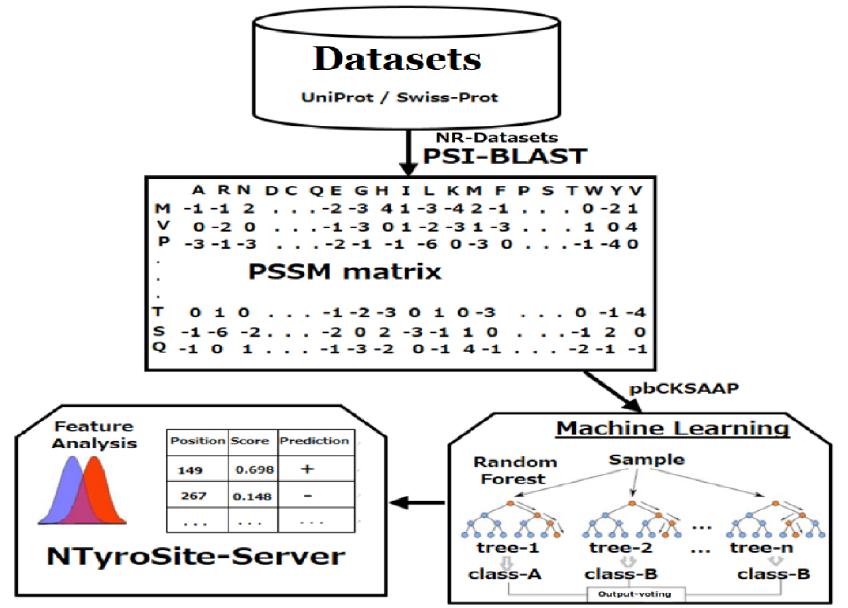
Figure 1. A computational framework of the proposed NTyroSite. NR—non-redundant; PSI-BLAST; PSSM—position-specific scoring matrix; pbCKSAAP—profile-based of k -spaced amino acid pairs.